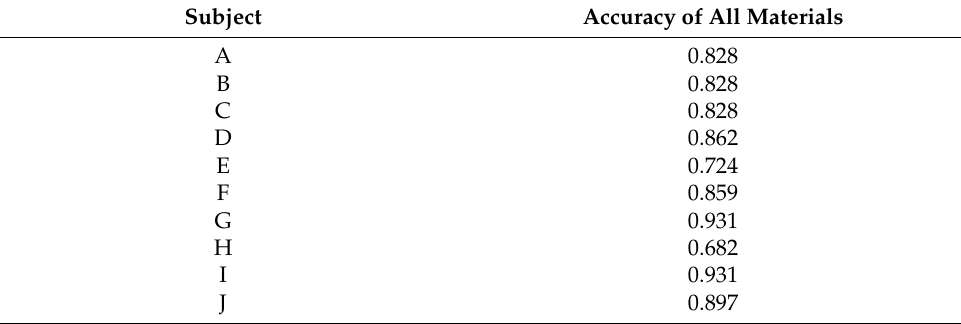
Table 8. Accuracy of all materials of each